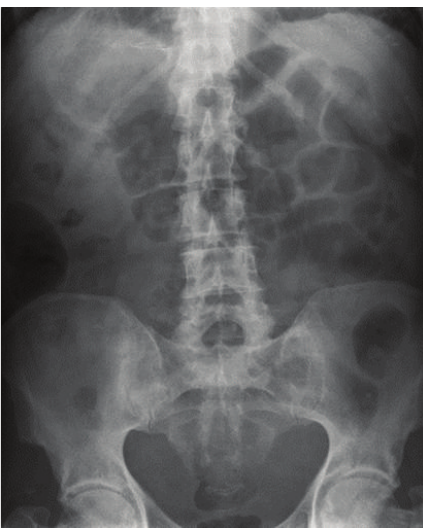
Figure 1: Plain abdominal radiography.